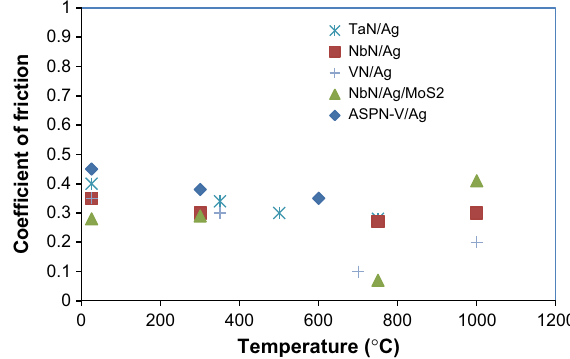
Figure 3. Recorded friction coefficient of TMeN/Ag system at different temperatures: NbN/Ag, NbN/Ag/MoS 2 [24], TaN/Ag [25], VN/Ag [26] and our research of